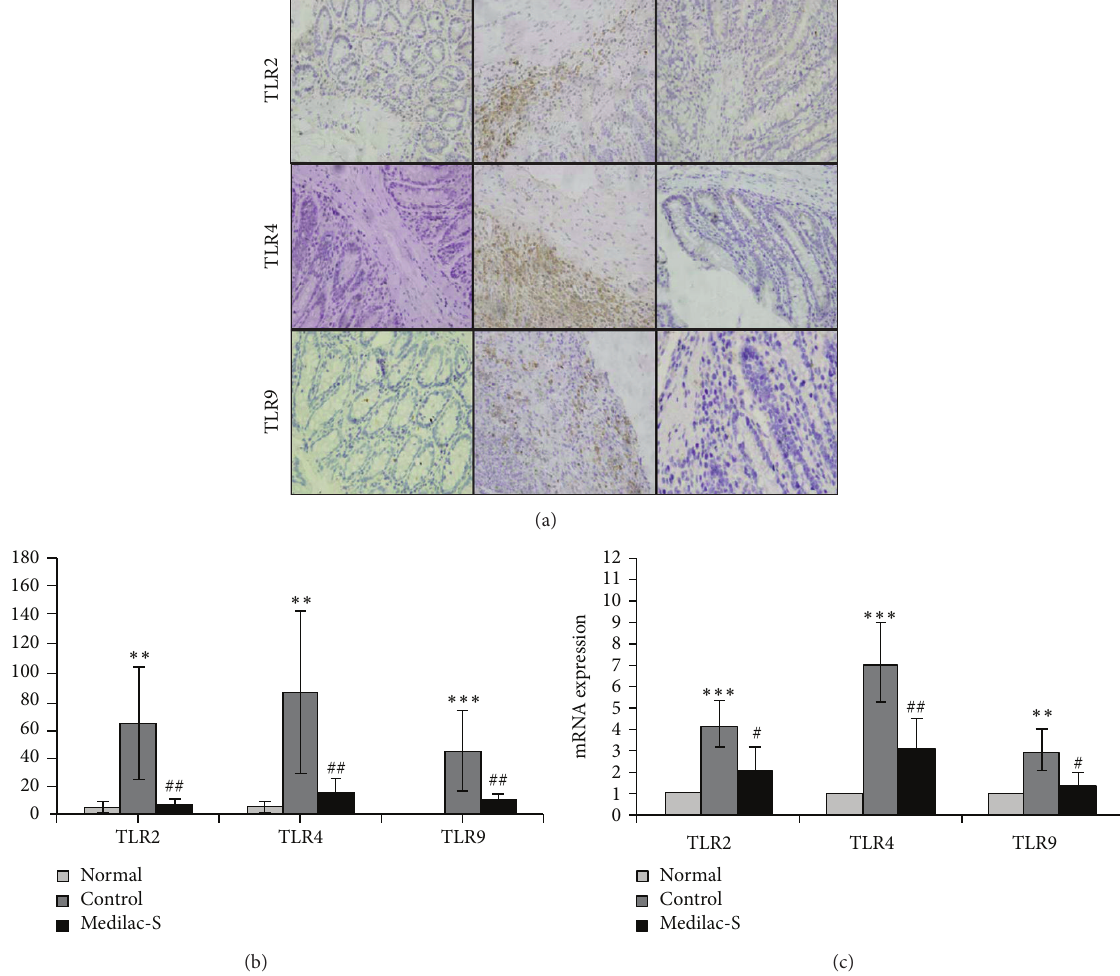
Figure 2: The expressions of TLRs in groups. (a) Immunochemistry of TLRs expressions in groups. (b) The mean numbers of positive cells per square millimeter of TLRs expressions were quantificated. (c) qRT-PCR analyzed the mRNA expressions of TLRs in groups. TLR2 and TLR4 were lowly expressed in normal intestinal tissues, while TLR9 was rarely expressed. After the establishment of experimental colitis, the expressions of TLR2, TLR4, and TLR9 were enhanced in the inflammatory cells which were located in lamina propria and submucosa. But after the treatment of Medilac-S the expressions of TLR2, TLR4, and TLR9 were all weakened. And the mRNA expressions in groups had the similar phenomenon ( 𝑛 = 10 per group; ∗ compared with normal group, # compared with control group, ∗ or # 𝑃 < 0.05 , ∗∗ or ## 𝑃 < 0.01 and ∗∗∗ or ### 𝑃 < 0.001